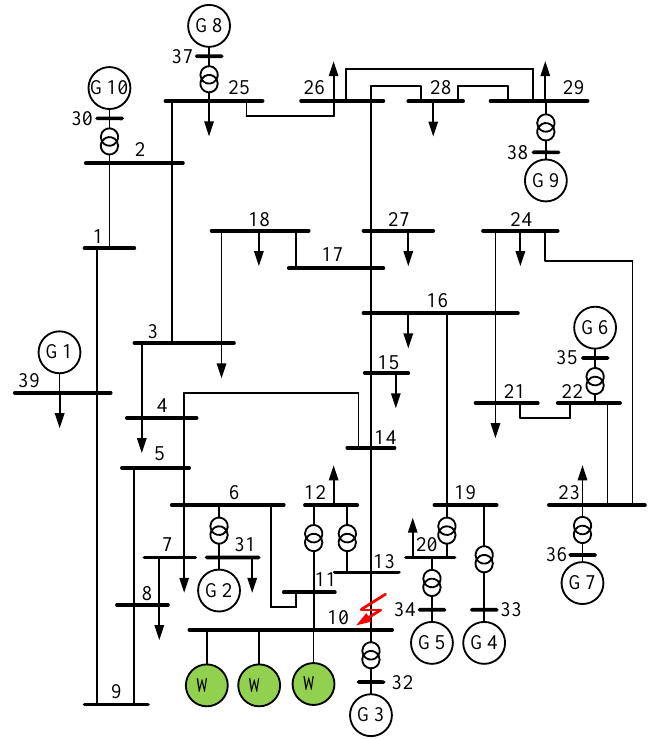
Figure 14. Institute of Electrical and Electronics Engineers (IEEE) 10-mahicne-39-bus system integrated with PMSG-based wind farms.